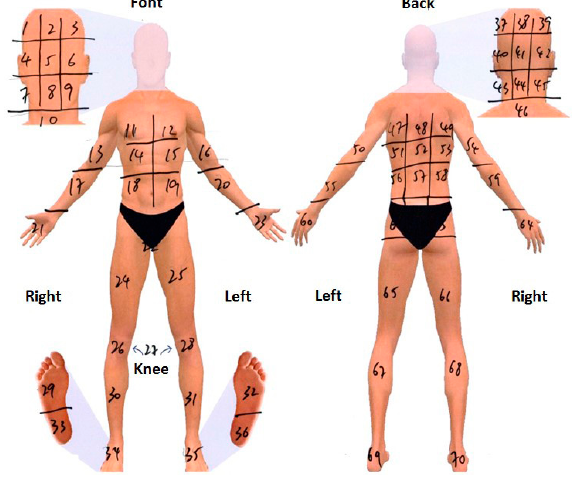
Figure 1. Body regions for the pain location measurement.